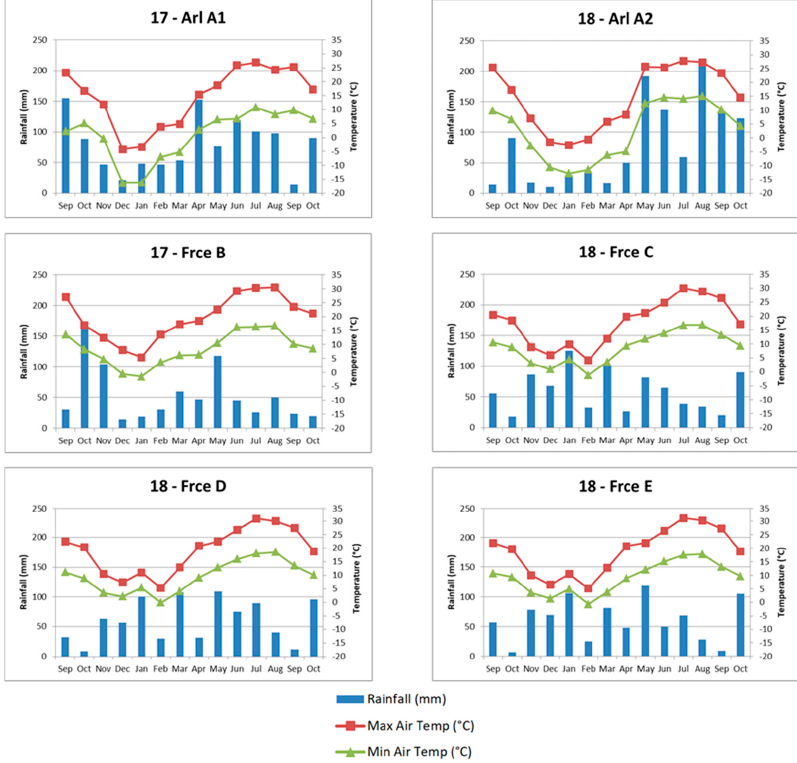
Figure 1. Monthly rainfall accumulation and average temperature for each of the six field locations